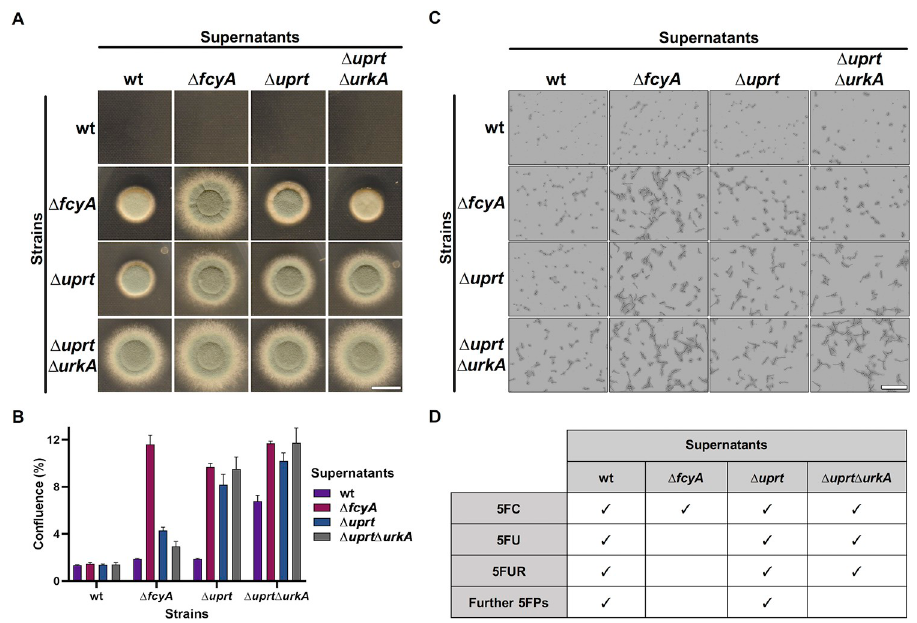
Fig 3. Growth inhibitory effects exerted by effluxed fluoropyrimidines on mutants lacking key pyrimidine salvage activities. (A) Evaluation of the supernatants’ impact on the colony growth of strains on solid medium. (B) Microtiter- based hyphal growth quantification and (C) representative microscopic images illustrating growth of strains in liquid AMM supplemented with distinct supernatants. (D) Prediction of the fluoropyrimidine content in supernatants of the respective strains. The susceptibility displayed by Δ uprt Δ urkA grown in the presence of wt and Δ uprt supernatants suggests the efflux of 5FUMP and/or further toxic fluoropyrimidines (5FPs). Scale bars: (A) 1 cm, (C) 100 μ m.